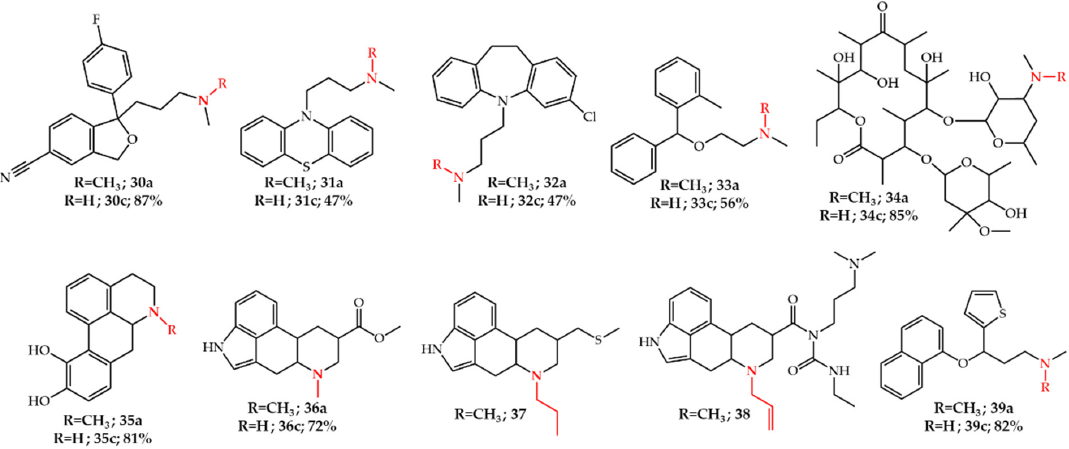
Figure 4. N ‐ Dealkylated drug metabolite synthesis with chloroformates. Figure 4. N -Dealkylated drug metabolite synthesis with